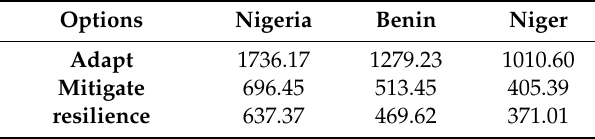
Table 12. Expected counts for combined data.